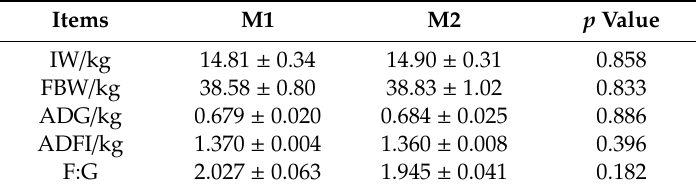
Table 2. E ff ects of feeding frequency on body weight and feed intake of growing pigs 1 .